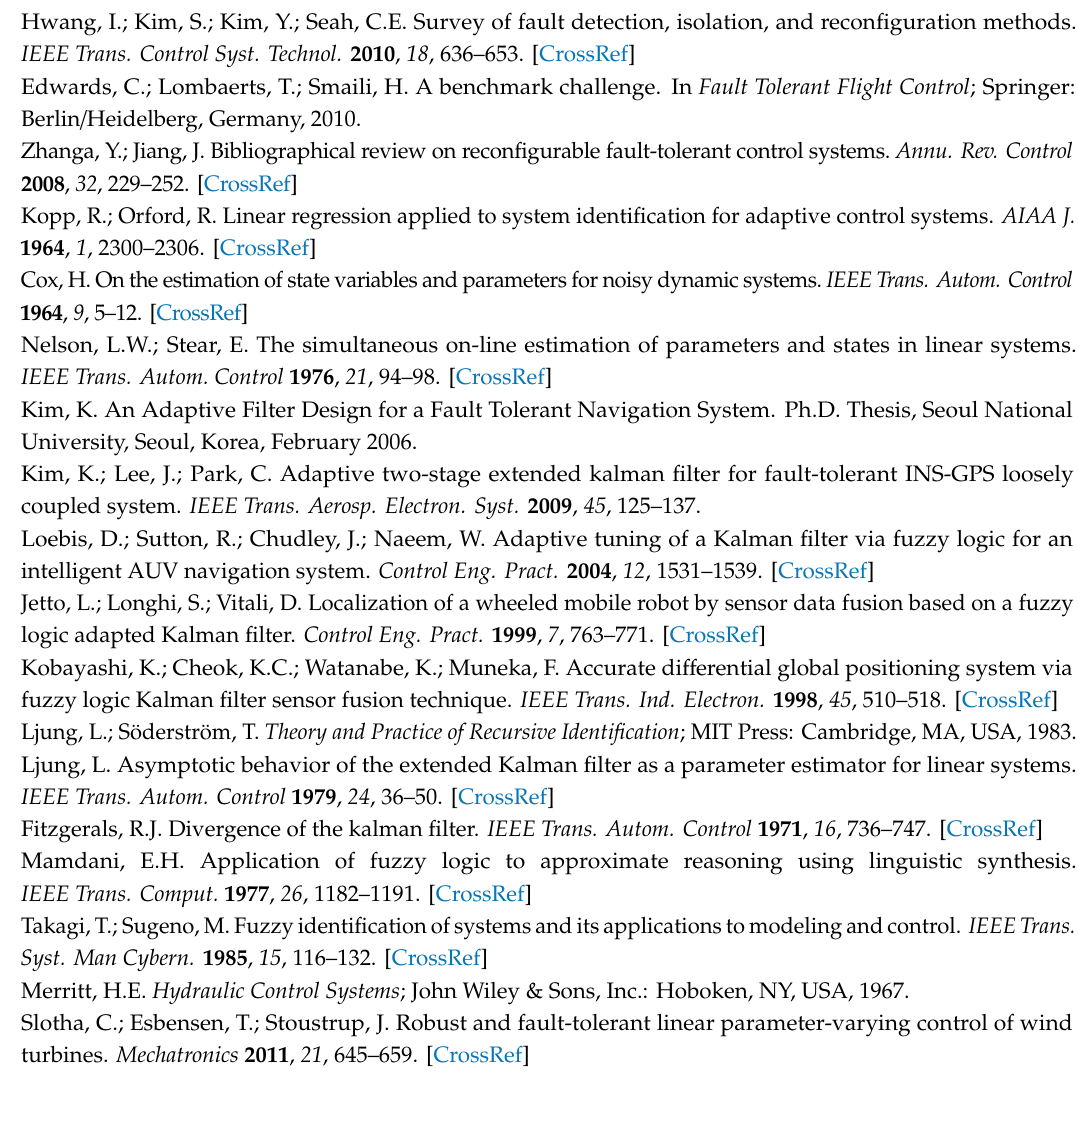
Figure A1. Results of parameter estimation using AFKF with different window lengths.